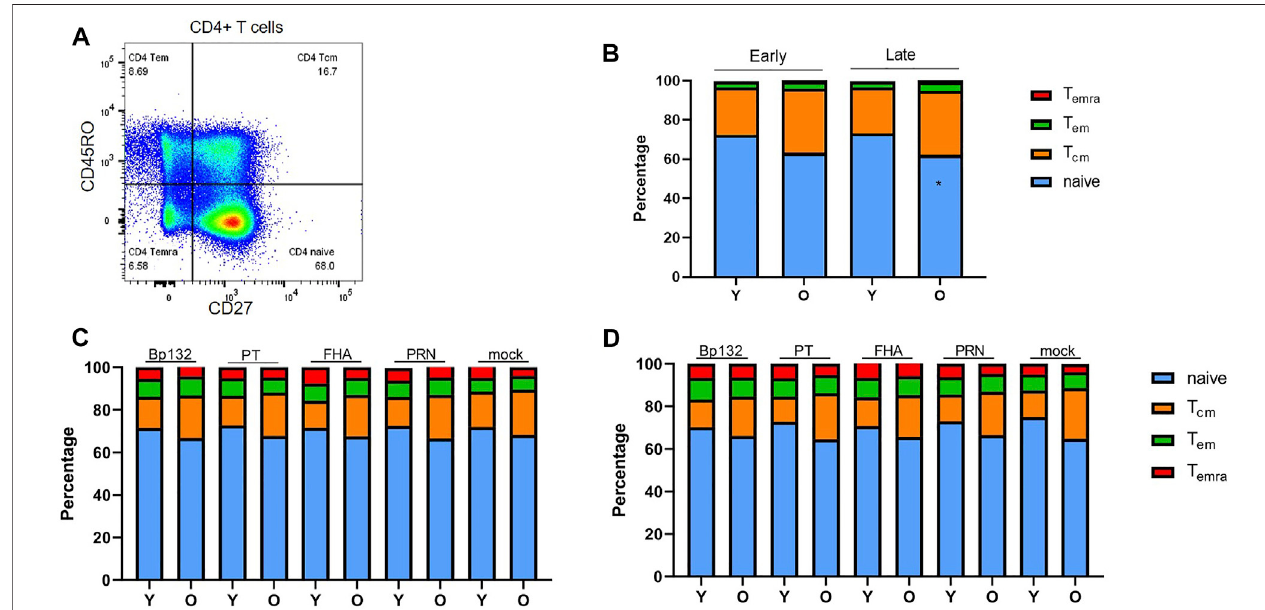
FIGURE4| Frequenciesof naïveand memorycells within theCD4 + T-cell population inlongitudinalPBMCsamplesofyoungsters(Y) and older adults (O)pre- and post in vitro culture. (A) Gating of naive and memory subsets based on CD45RO and CD27 expression. (B) Proportion of naïve/Tem/Tcm/Temra subsets within the CD4 + T-cell population at early and late phase prior to stimulation; (C) after 6-day antigenic stimulation in the early phase; and (D) after 6-day antigenic stimulation in the late phase. Stacked bars indicate median relative percentage of subsets per age group and timepoint. Statistical signi fi cance of proportional differences between CD4 + T-cell subsets of youngsters and older adults was calculated with Mann Whitney U -test. * p < 0.05.